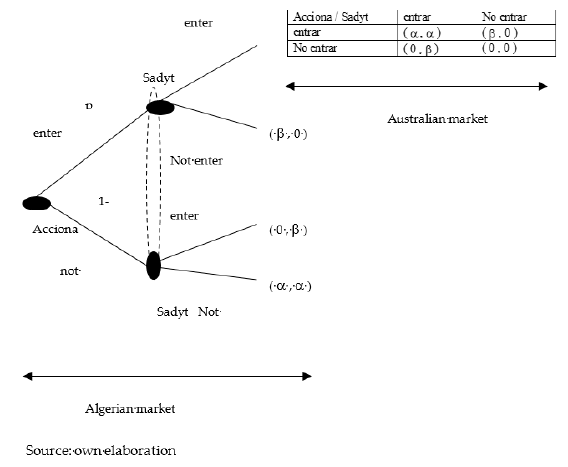
Figure 4. Representation of the game.